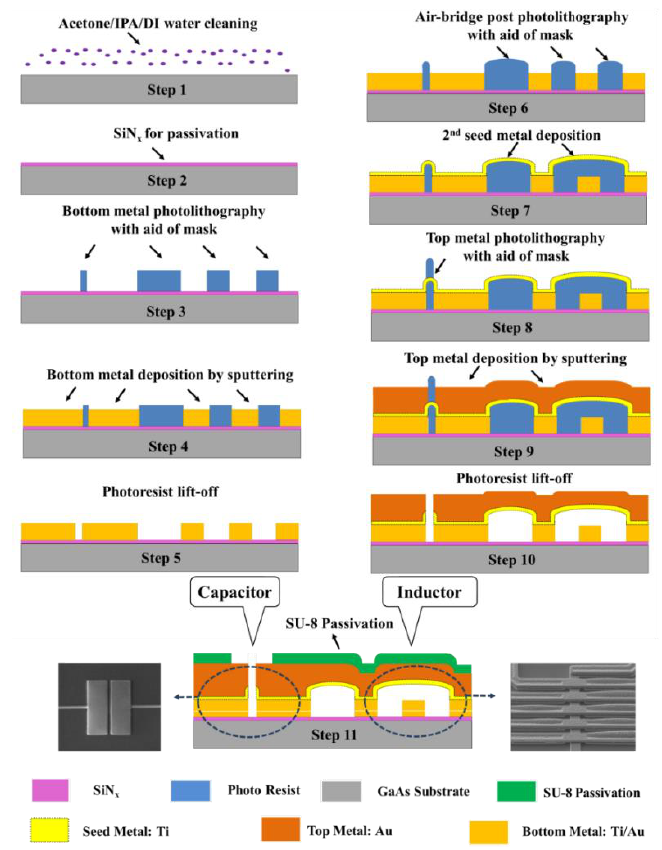
Figure 2. The fabrication process flow of the proposed biosensor.